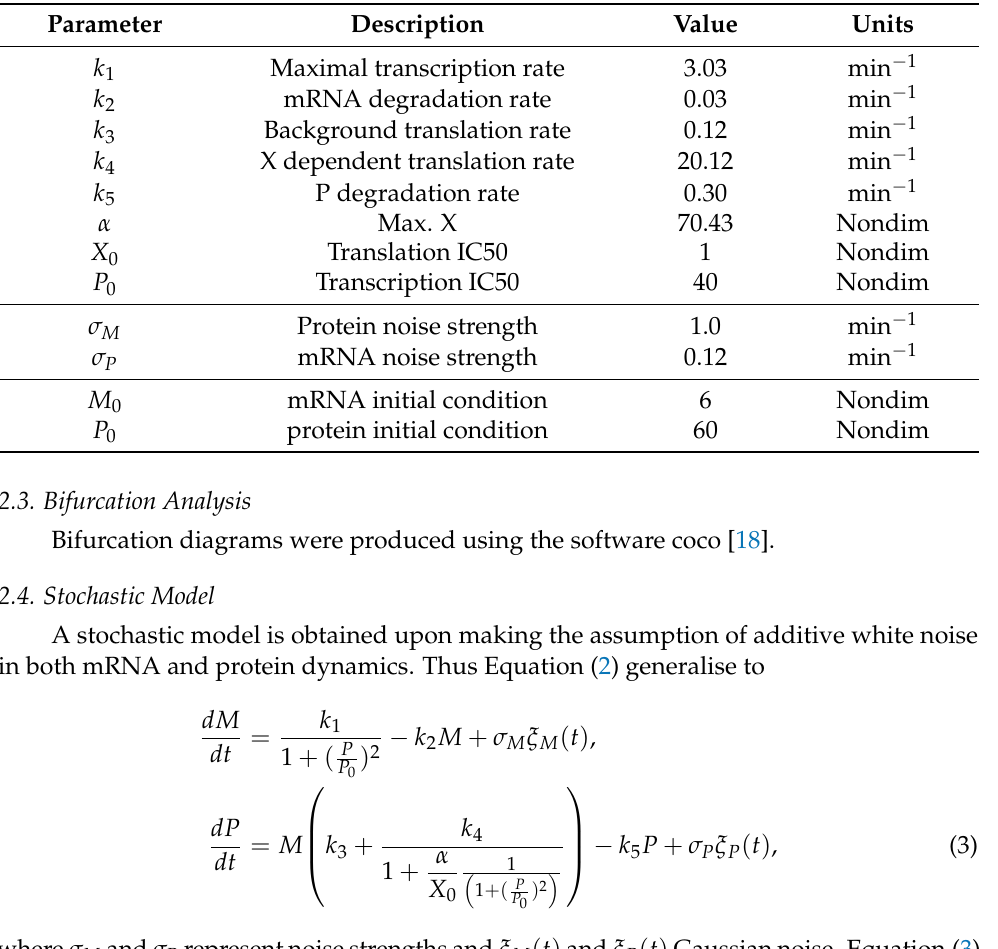
Table 1. A table of parameter